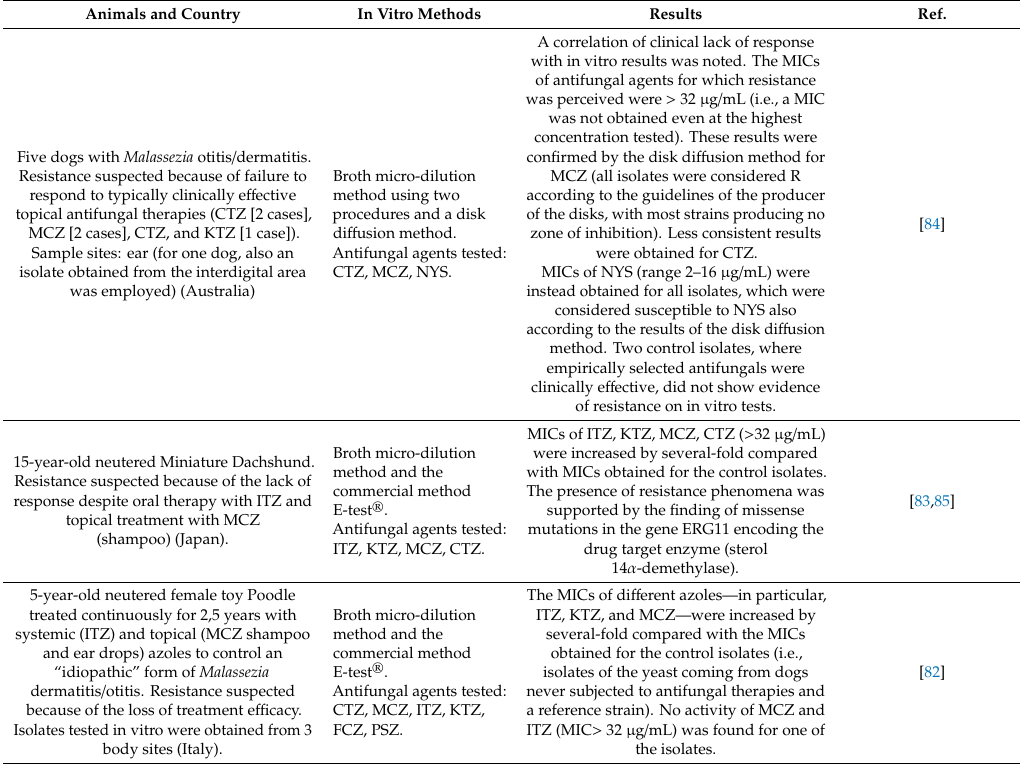
Table 2. Summary information regarding 7 cases of treatment failure due to antifungal resistance of M. pachydermatis (see Document S1 for further